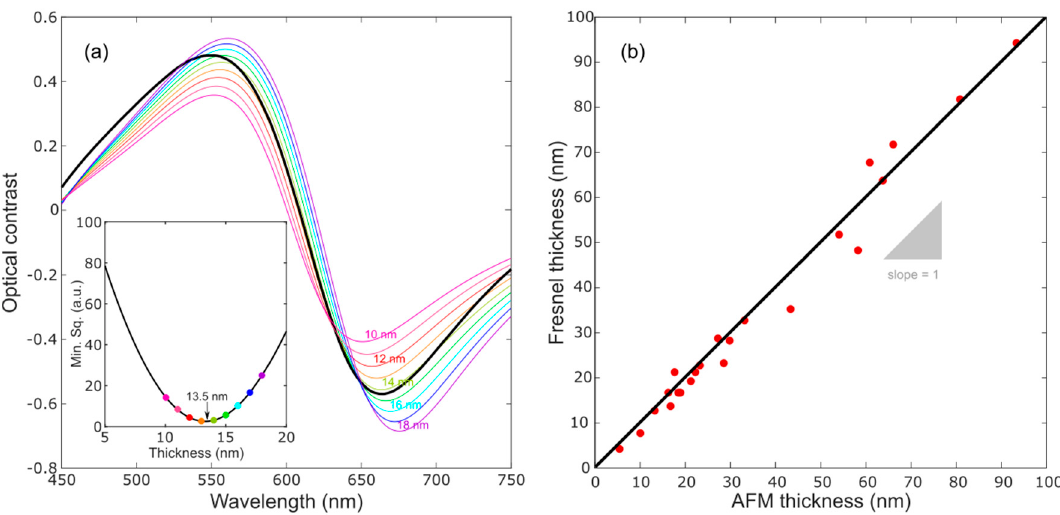
Figure 5. ( a ) Experimental optical contrast (black) and comparison with the calculated ones (color lines) of MoO 3 flakes, with thicknesses from 10 to 18 nm, placed onto a substrate of 297 nm of SiO 2 . Inset of figure: minimum square value for different values of thickness of the flakes. ( b ) Comparison of thickness measured with AFM and the Fresnel model. Experimental data represented as red dots and line in black has a slope of 1.